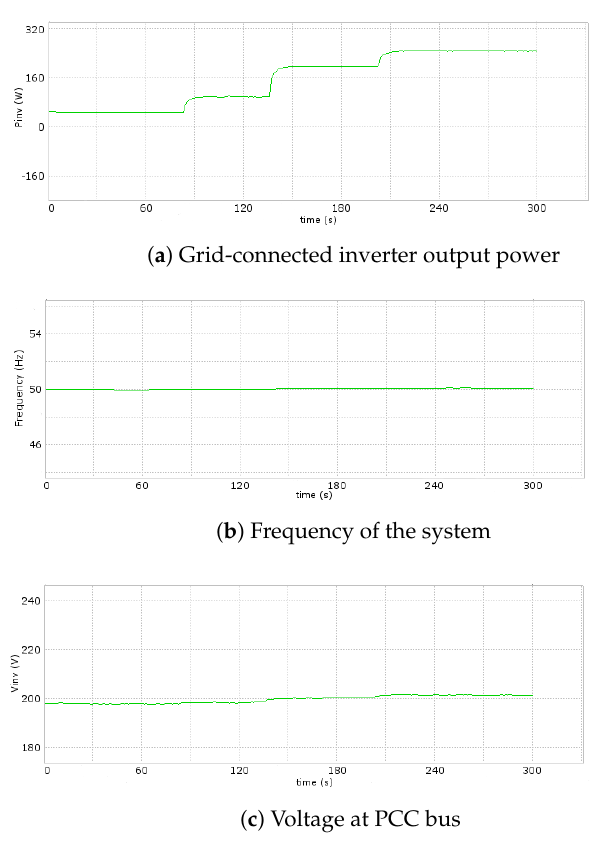
Figure 19. Experiment results of constant power control on three-phase grid-connected operation.